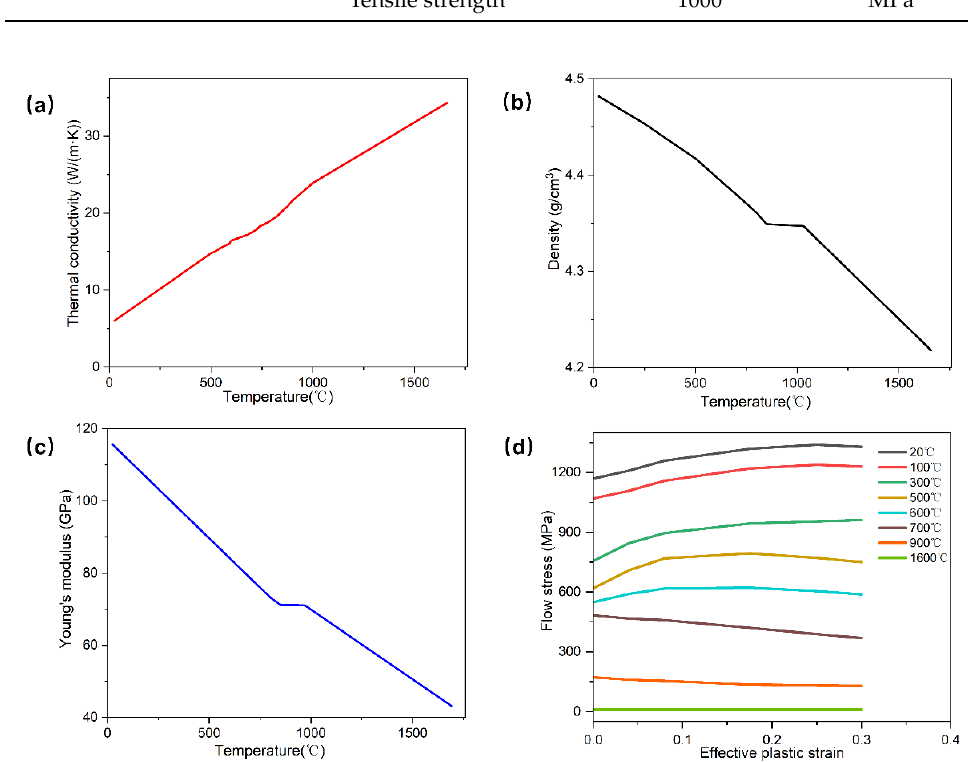
Figure 3. Physical properties of Ti-6Al-4V used in the simulations. ( a ) Thermal conductivity, ( b ) density, ( c ) Young’s modulus , and ( d ) flow